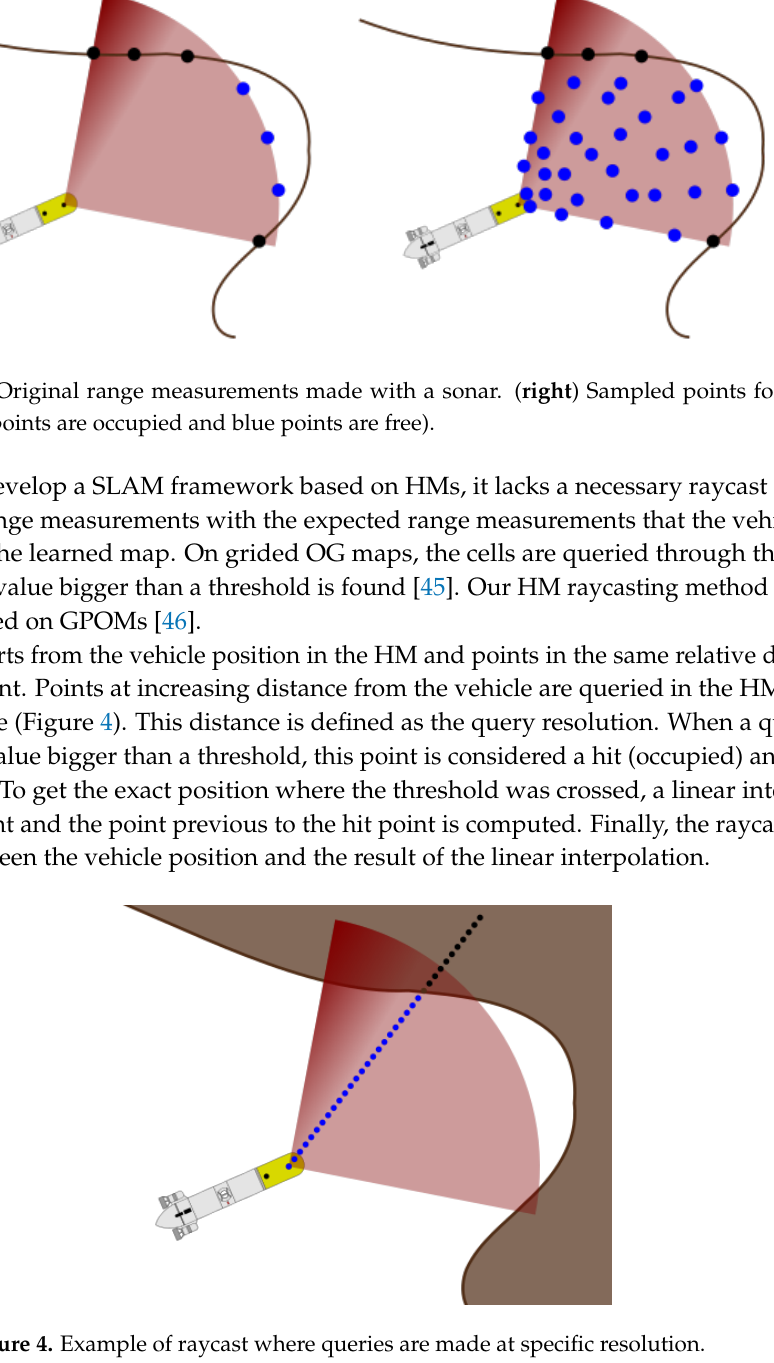
Figure 4. Example of raycast where queries are made at specific